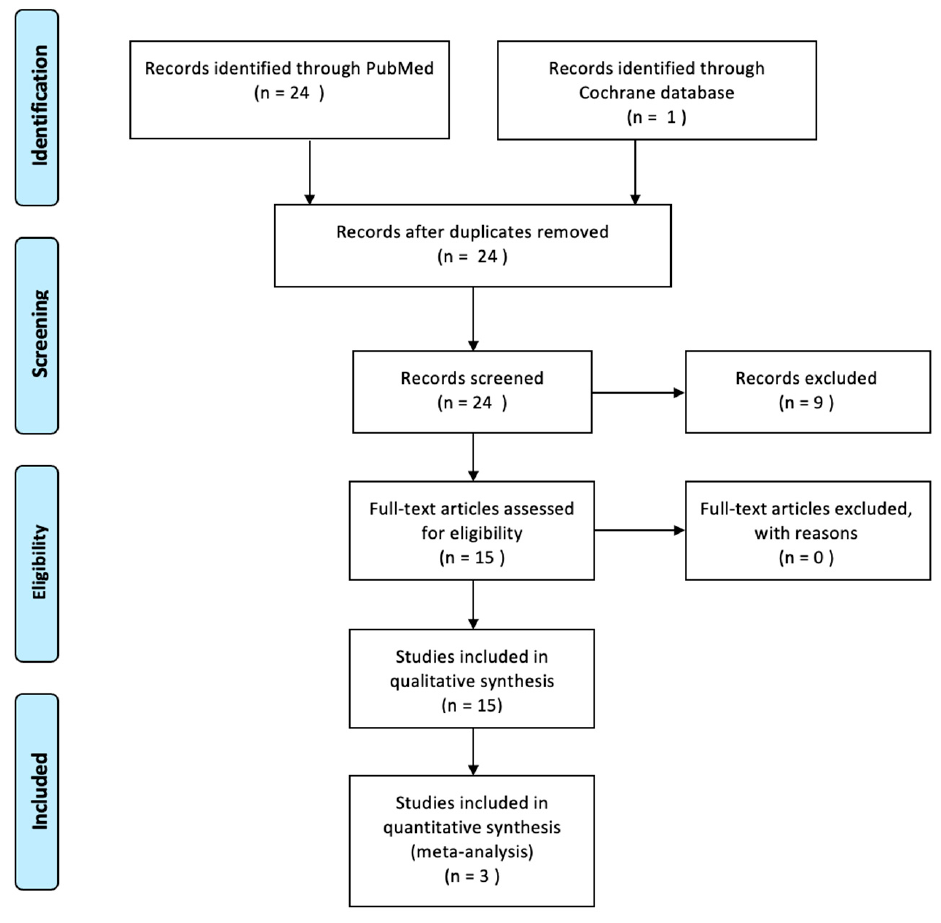
Figure1. PreferredReportingItemsforSystematicReviewsandMeta-Analyses(PRISMA)flowdiagram. Figure 1. Preferred Reporting Items for Systematic Reviews and Meta-Analyses (PRISMA) flow diagram.